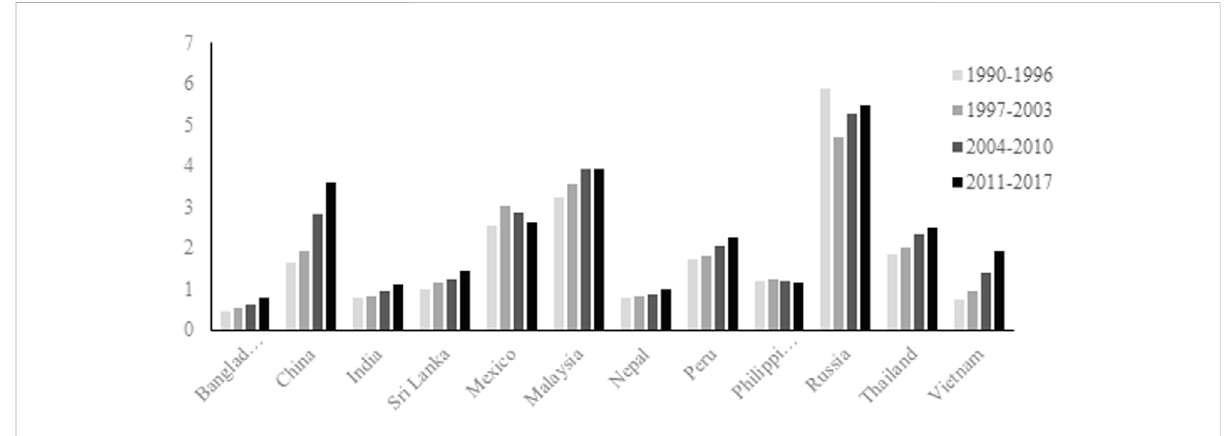
FIGURE 1 Average value of the ecological footprint in different time